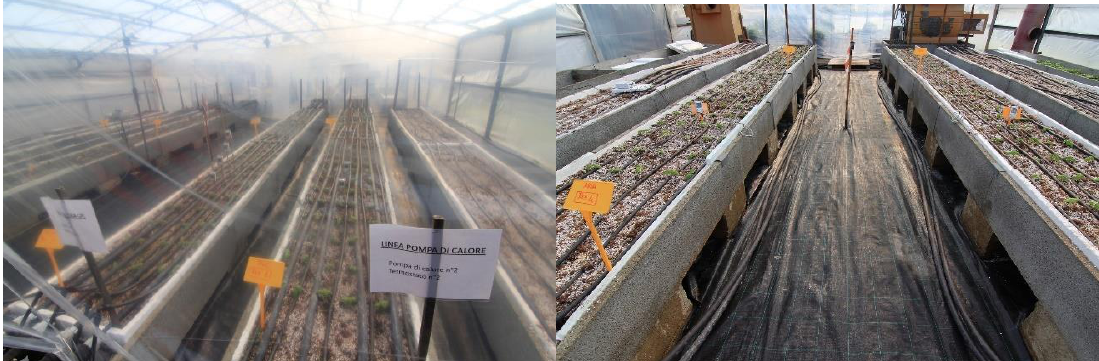
Figure 2. Global layout of the experimental greenhouse (basal side on the left and air side on the right).